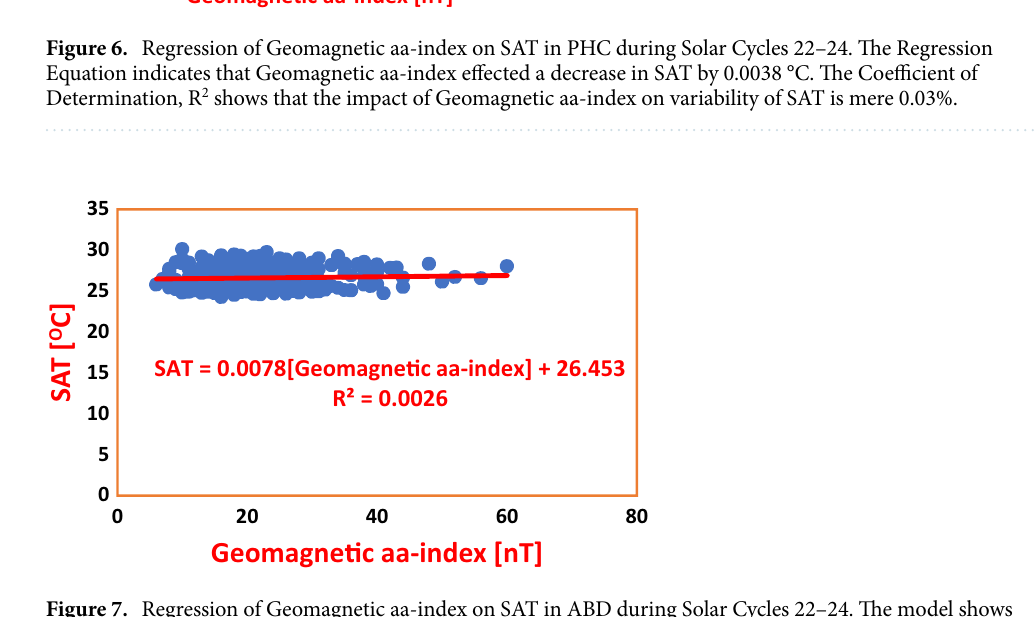
S/N Climate station Regression equation Coefficient of determination Influence (%) Average influence